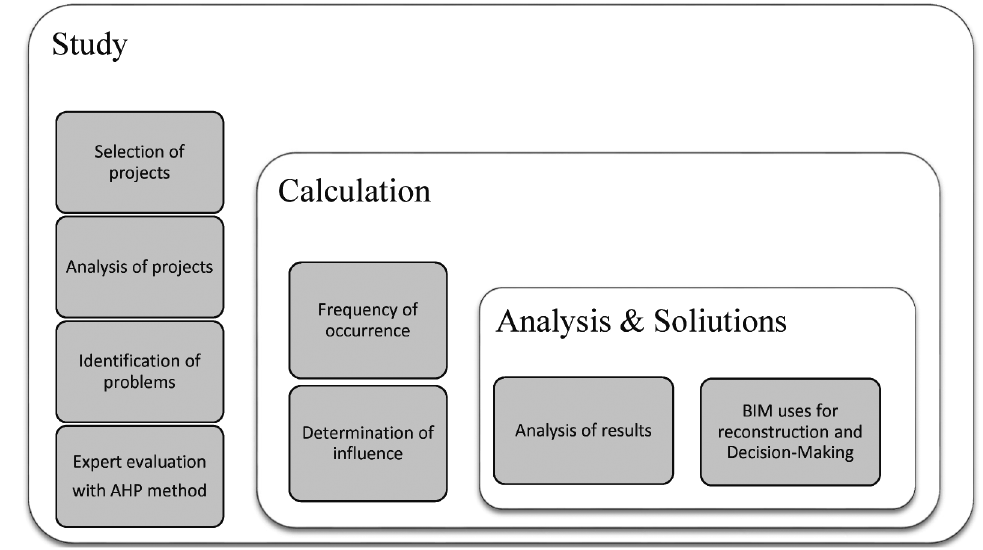
Fig. 1. Methodology of